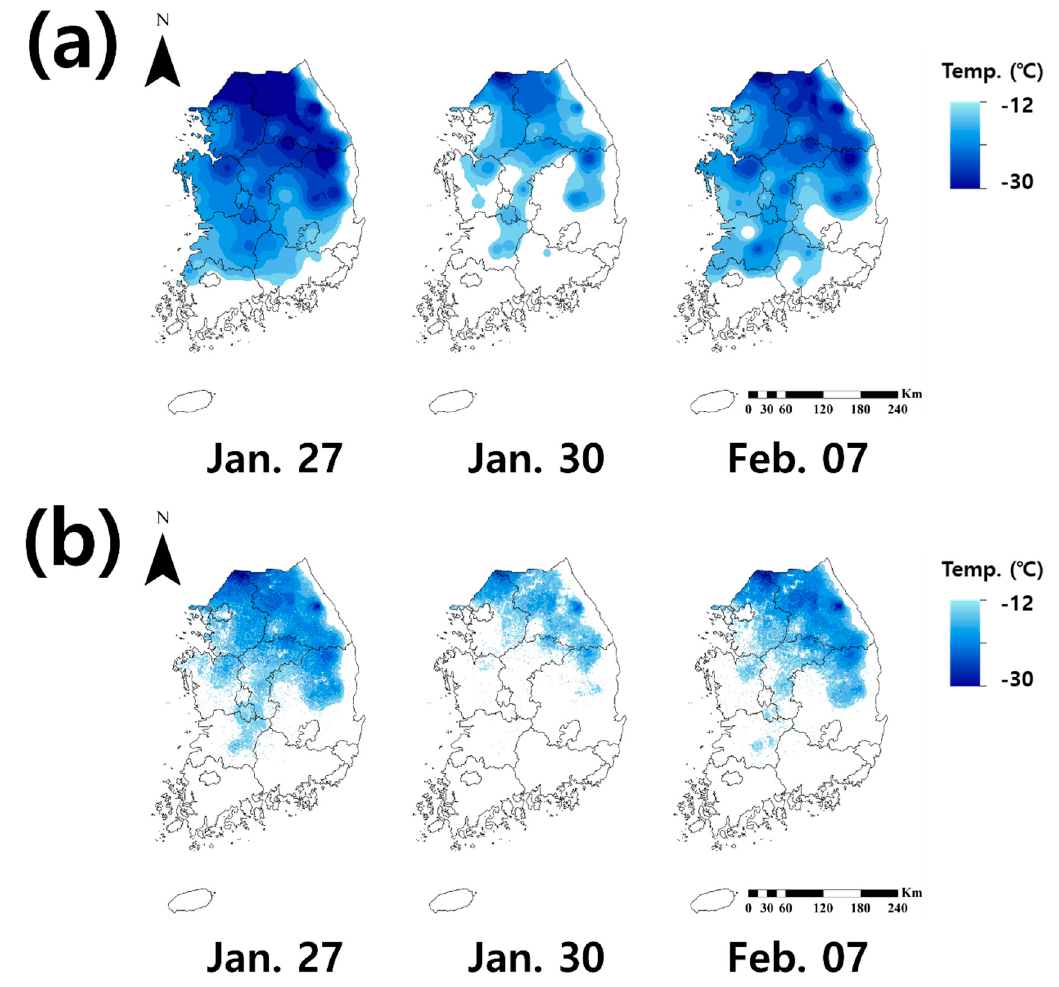
Figure 8. Spatial T MN distribution of ( a ) observed T MN and ( b ) predicted T MN on January 27, January 30, and February 7, 2018, during the cold wave period. The temperature range was set from − 12 to − 30 °C to express the distribution of cold wave occurrence.